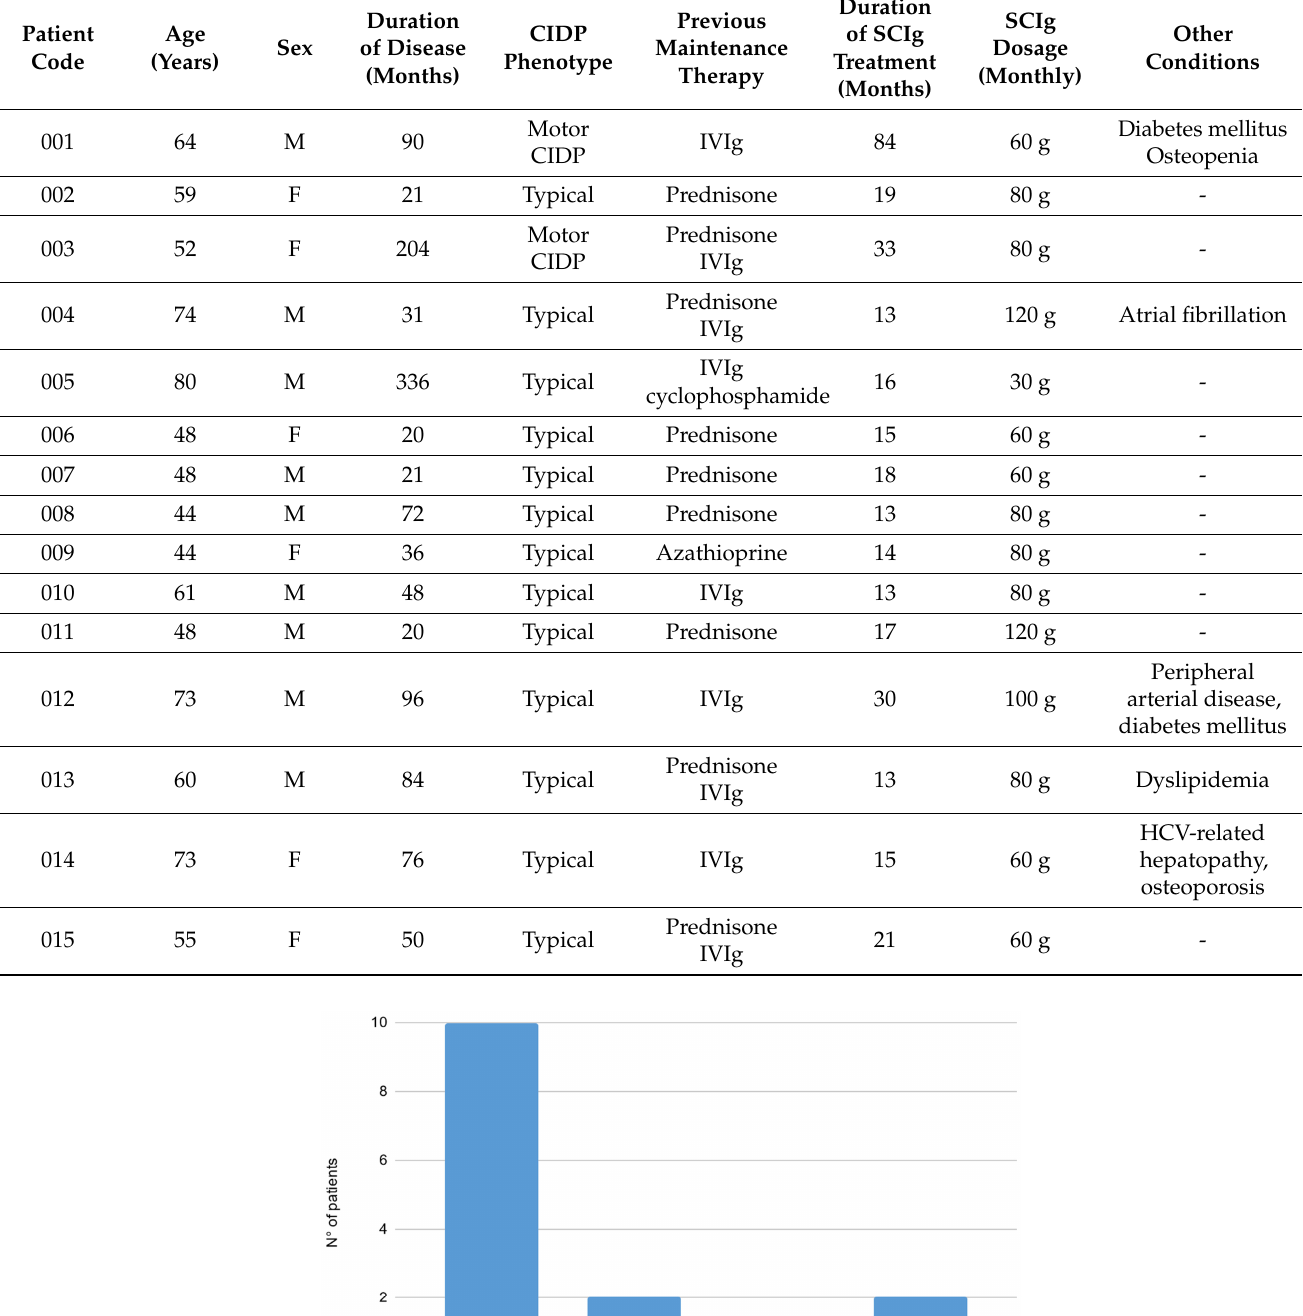
CV registered from the right peroneal nerve improved at follow-up (29.82 vs. 44.78 m/sec; p = 0.15). Table 1. Clinical data in our cohort of CIDP patients treated with SCIg. Chronic inflammatory de- myelinating polyneuropathy, CIDP; intravenous immunoglobuline, IVIg; subcutaneous immunoglob- ulins, SCIg.